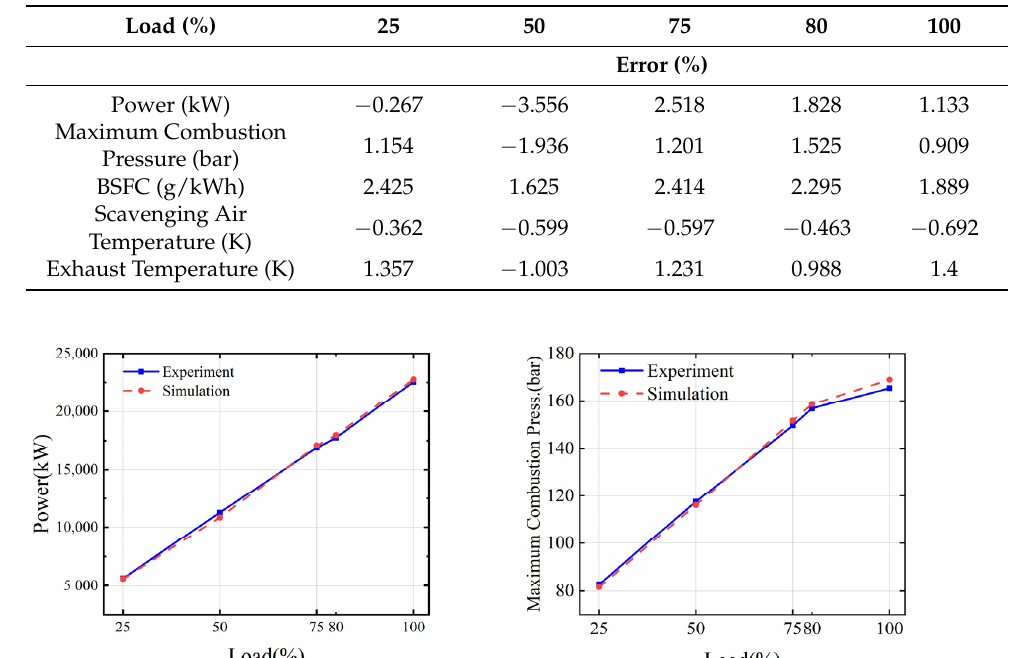
Table 4. Calculation errors of parameters in diesel mode.